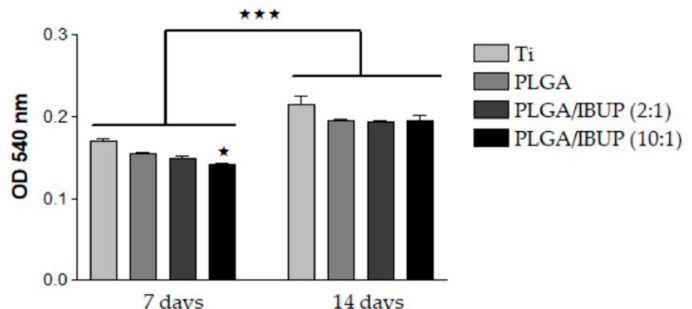
Figure 11. Collagen synthesis of human fibroblasts grown on PLGA-based coatings for 7 and 14 days (cid:70) p (Sirius Red assay), < 0.05 vs. uncoated Ti substrate;